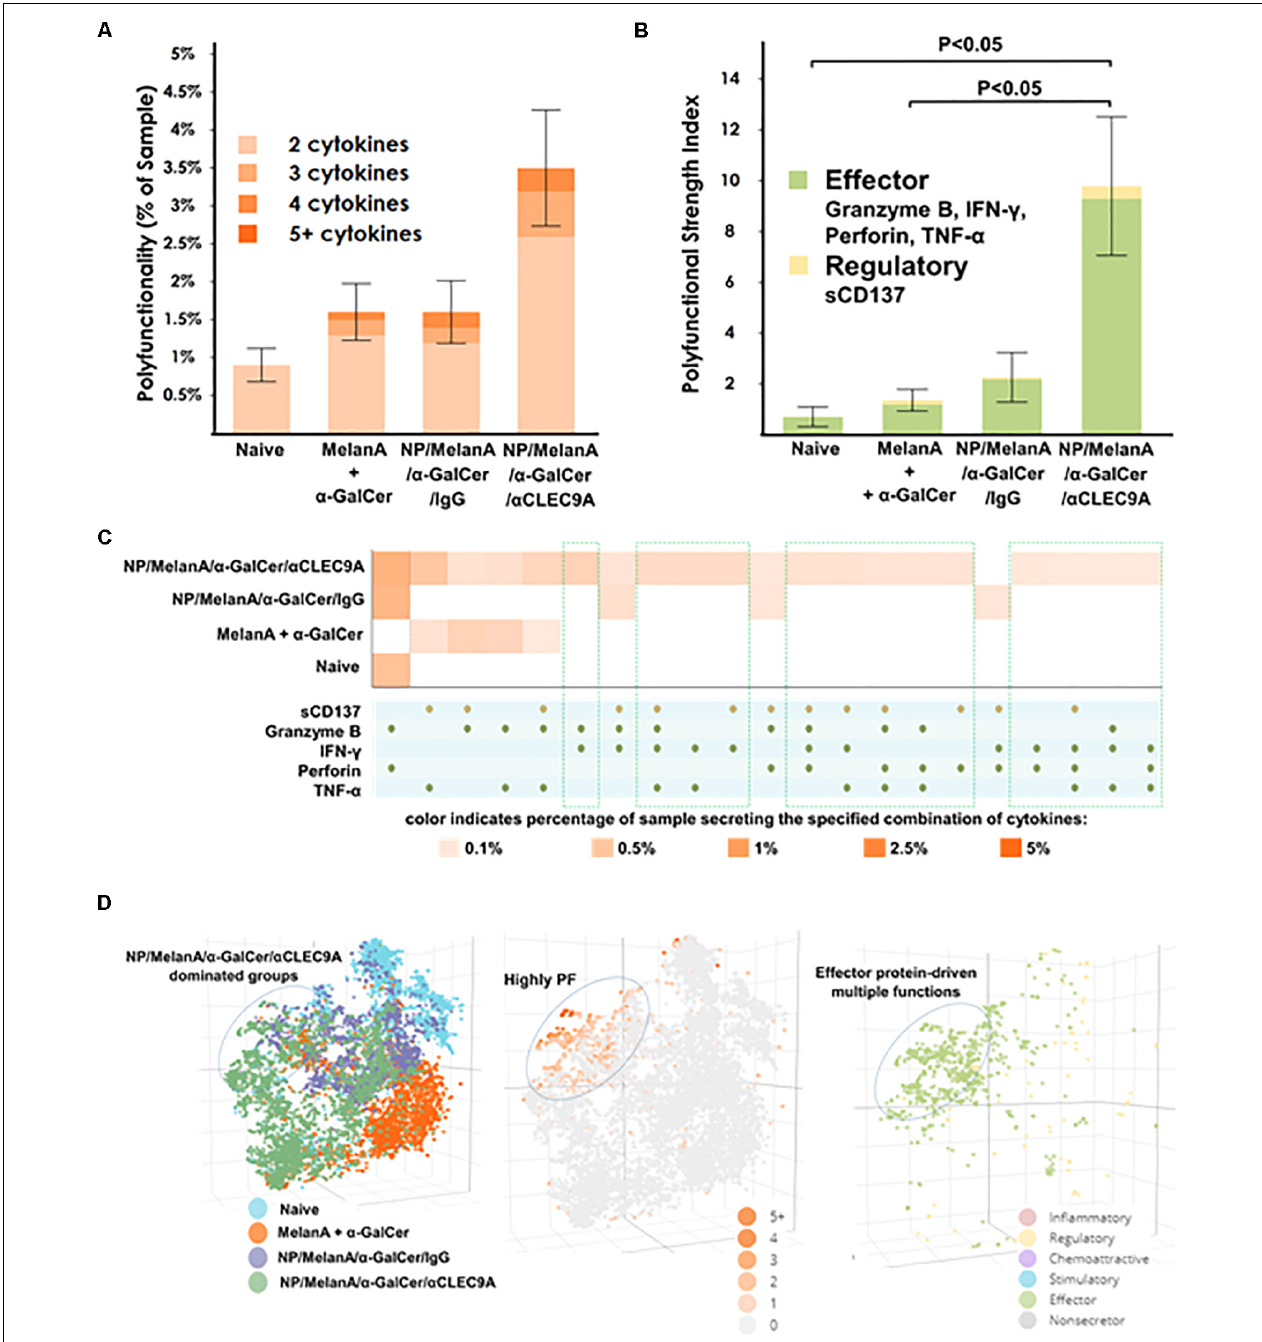
FIGURE 5 | Polyfunctional human CD8 + T cells induced by the NP-Melan-A vaccines as determined by single cell-based multiplexed proteomics. (A) The NP-Melan-A vaccines resulted in an upregulation of polyfunctionality and (B) polyfunctional strength index (PSI). (C) Heat map identified an increase of polyfunctional cell subsets (multiple secreted cytokines) in the vaccinated mice compared to naive mice. Results are displayed as the mean value and standard error ( n = 5). (D) 3D t-SNE visualization dissected high-dimensional single cells and revealed highly upregulated polyfunctionality of CD8 + T cells with effector protein-driven multiple functions upon NP-Melan-A vaccines. Statistical analyses were performed using Mann-Whitney U test and differences were considered if P < 0.05.